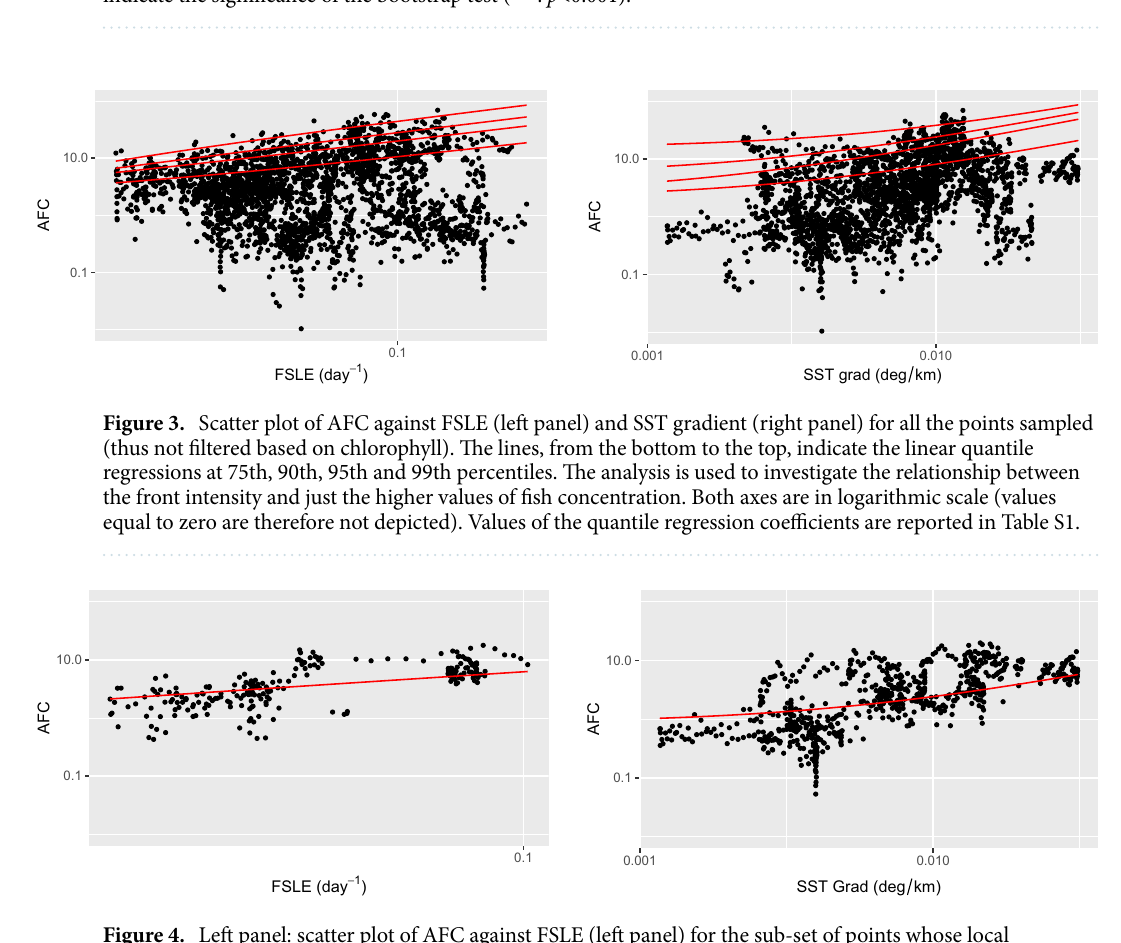
Figure 2. Bootstrap method results. AFC values were separated according to the respective FSLE and SST gradient values, using a threshold as a limit to define a front (0.08 days − 1 and 0.009 Light gray columns represent the mean AFC under the respective threshold, considered outside a front. Dark gray columns represent the mean AFC over the threshold, thus in proximity of a front. Left columns refer to FSLE analysis, right columns to SST gradient. Error bars indicate the standard deviation, while black stars indicate the significance of the bootstrap test (***: p <0.001).